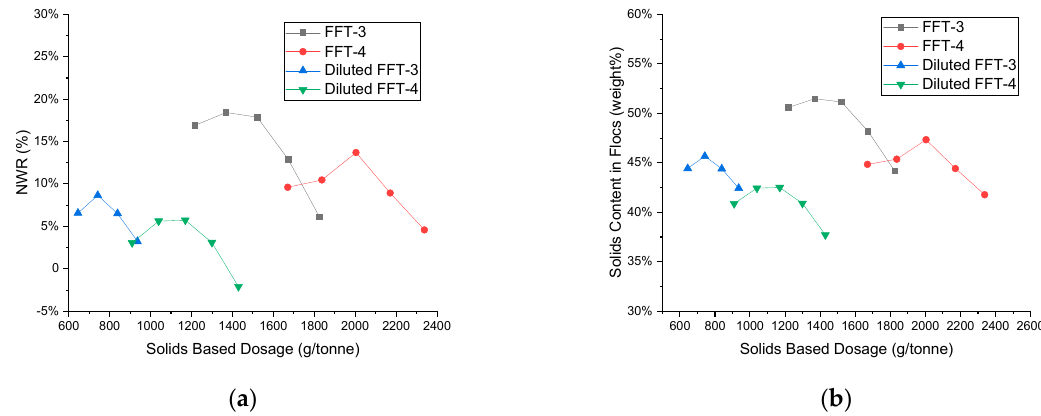
Figure 11. Dosage curves of 2 FFT and diluted FFT samples treated with polymer A3338: ( a ) NWR results corresponding to the polymer dosage; ( b ) the solids content in flocs corresponding to the polymer dosage. Each dot is the average value of duplicate or triplicate testing results.